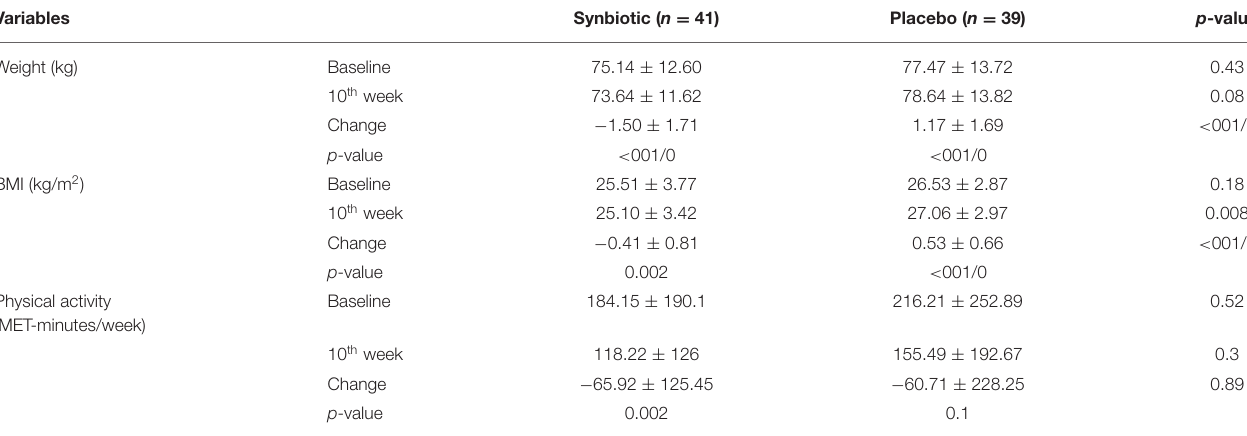
TABLE 2 | Anthropometric indices at baseline, at the end of the study and changes between the synbiotic and placebo groups.